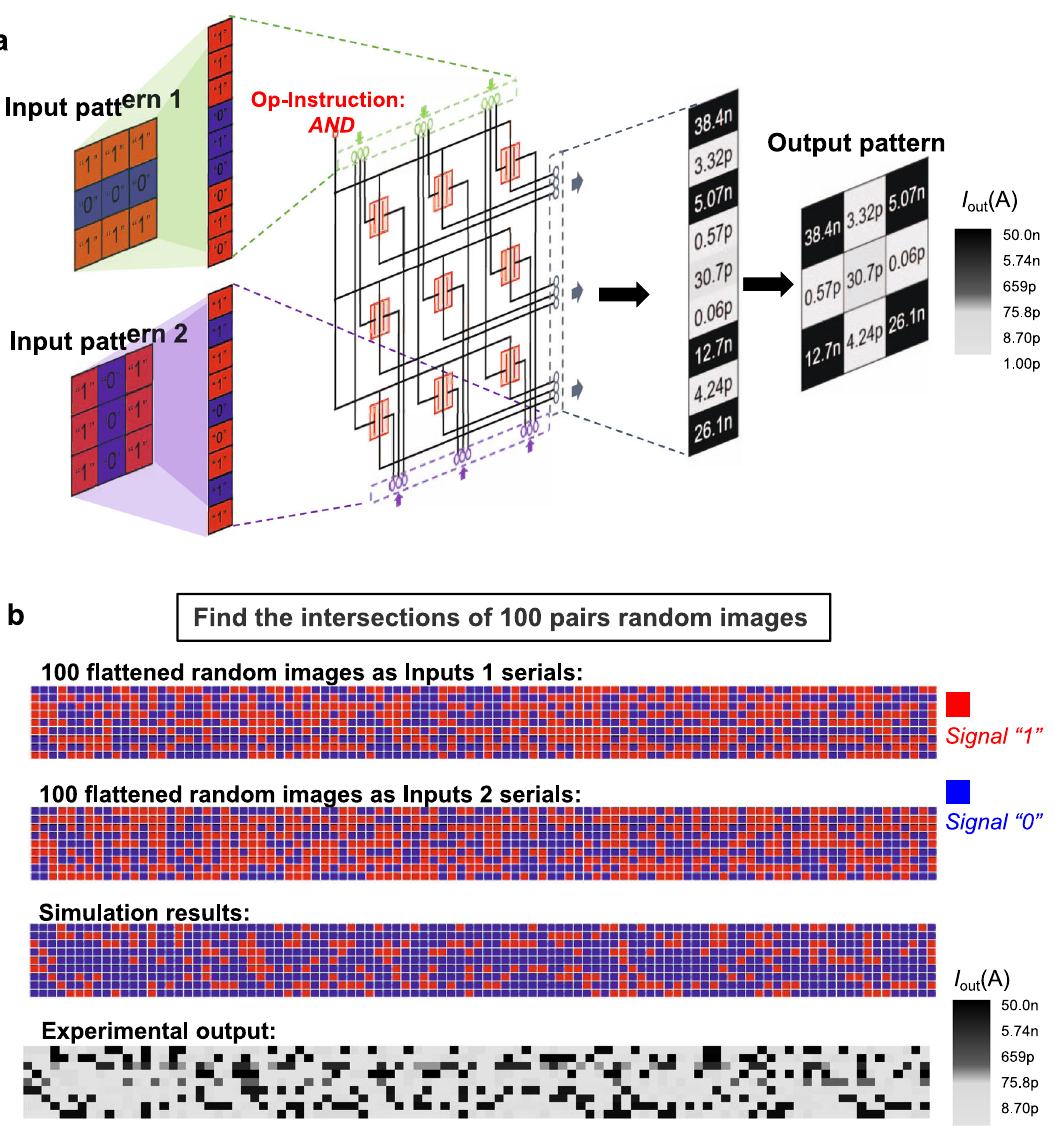
Fig. 4 Demonstration of the images intersection function based on logic AND . a Diagram of the working process of images intersection function. Two 3 × 3-pixel patterns are input in parallel from each of the two input ports of the pixel process units. The current of each pixel serves as the output signal. b A total of 100 pairs of 3 × 3-pixel graphs are randomly generated, the signal “ 1 ” and “ 0 ” refer to − 2 V and − 9 V respectively. All the random patterns are expanded in the manner shown in a , the 3 × 3-pixel patterns are represented in the way of 9 × 1, and 100 groups of graphs are combined. Then the fl attened input patterns serials are shown as the fi rst and second rows. The third row shows the truth table of the fl attened computing results. The red blocks and blue blocks represent the output “ 1 ” and “ 0 ” (computing results of logic AND ). The fourth row is the actual output current value which is consistent with the truth